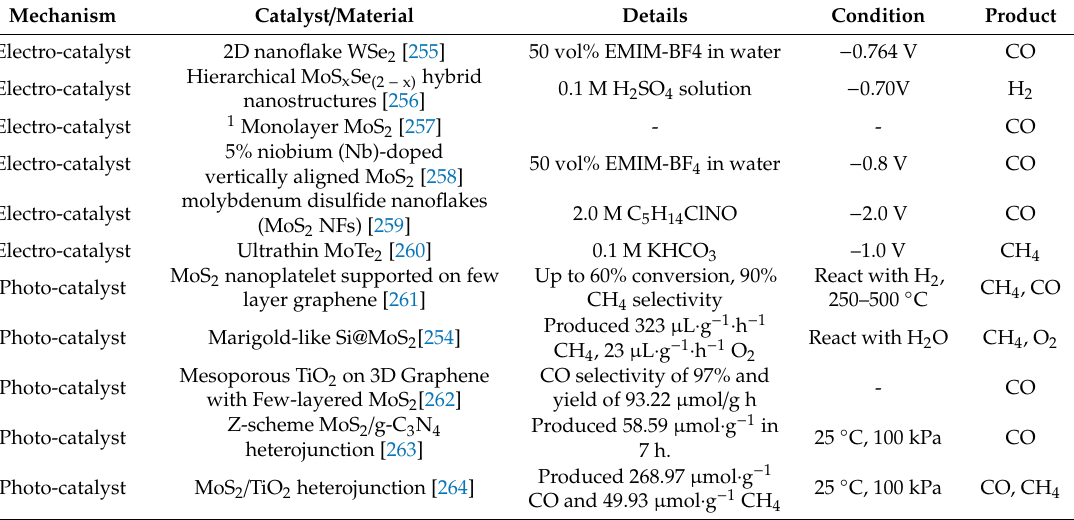
Table 4. Application of TMDCs in CO 2 conversion to syngas and other gases.